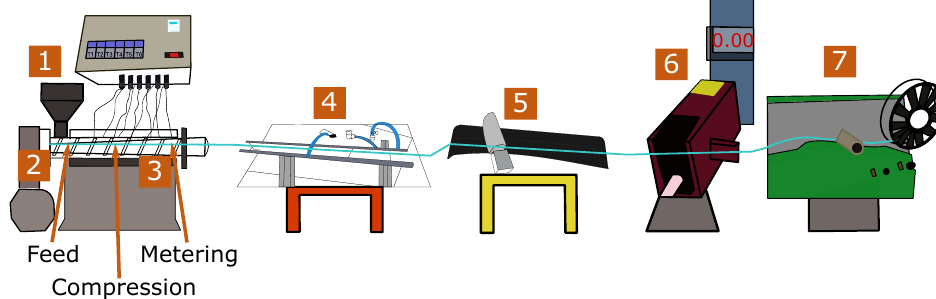
Figure 5. Extrusion set-up assembly constituting the production of (un)reinforced PLA filaments. (1) Hopper, (2) nozzle for the potential reinforced filament production, (3) processing screw with 3 sections (feeding, compression and metering), (4) water bath, (5) conveyor belt, (6) laser diameter controller, (7) filament winding station.